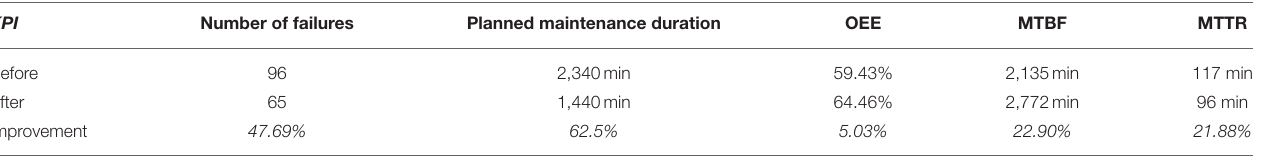
TABLE 8 | Evaluation results of KPIs in the steel industry. KPI Number of failures Planned maintenance duration OEE MTBF